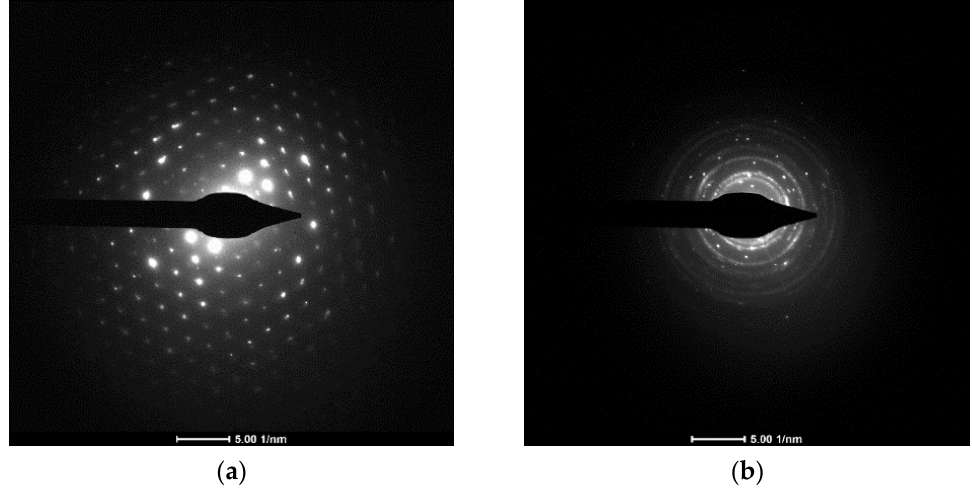
Figure 5. SAED pattern of ( a ) cement and ( b ) concrete